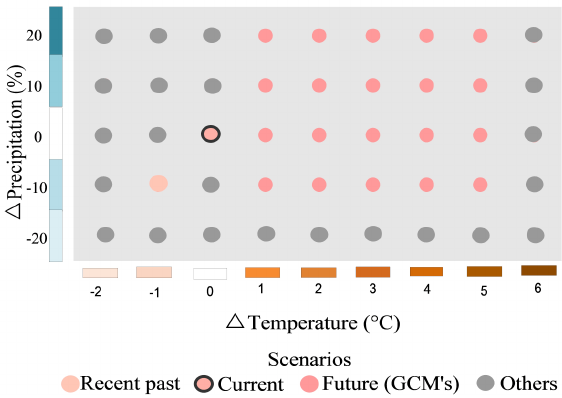
Figure 4. Exposure space. The salmon circle with a black border represents current conditions, the pale salmon circle represents the recent past, the dark salmon circles represent projected scenarios from GCM, and the gray circles are other scenarios. The Y–axis shows precipitation changes in percent (%), and the X–axis shows temperature changes in °C. Table 2. Calibration and validation outcomes. KGE: Kling–Gupta efficiency. NRMSE: root–mean– square error normalized by the mean of the flows. PBias: percent bias. ID